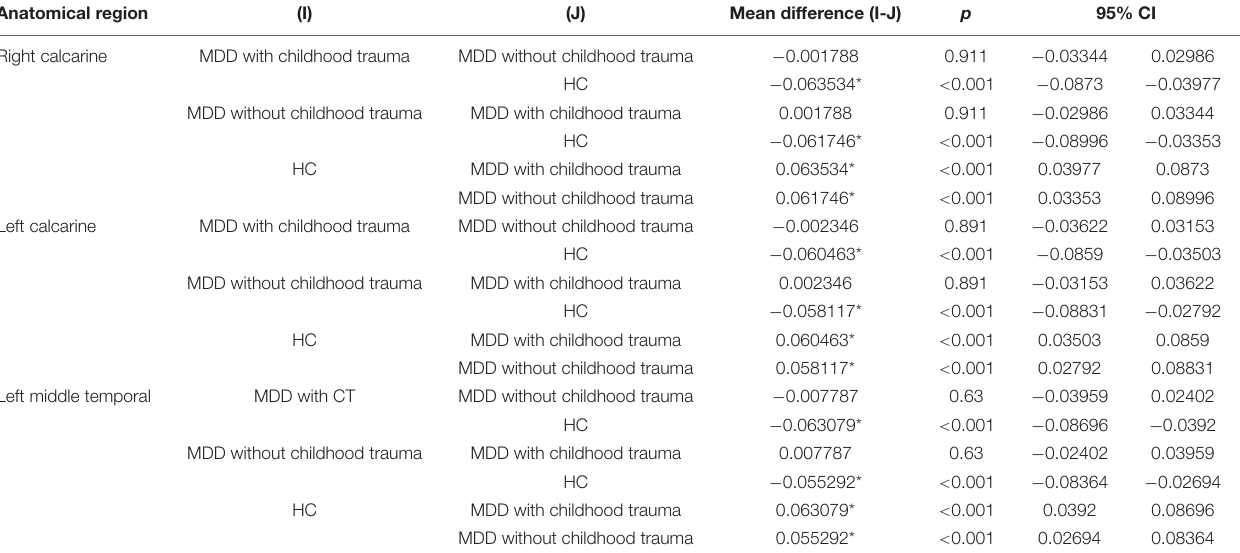
TABLE 6 | Multiple comparisons in regions with differences in voxel-wise concordance.